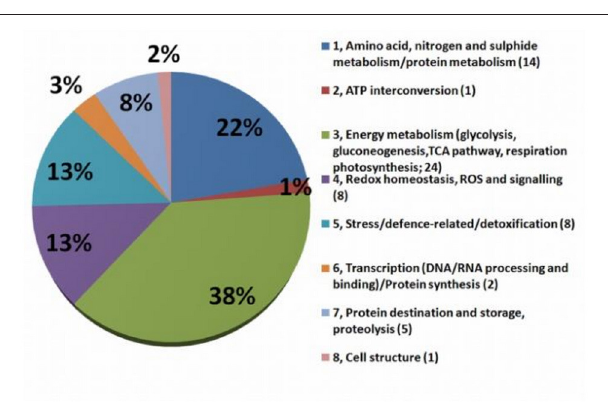
FIGURE 5 | Graph of functional groups. The functional classification of MDE proteins differentially accumulated after 7 days after stress ( n = 65). The numbers in brackets are numbers of proteins involved in each